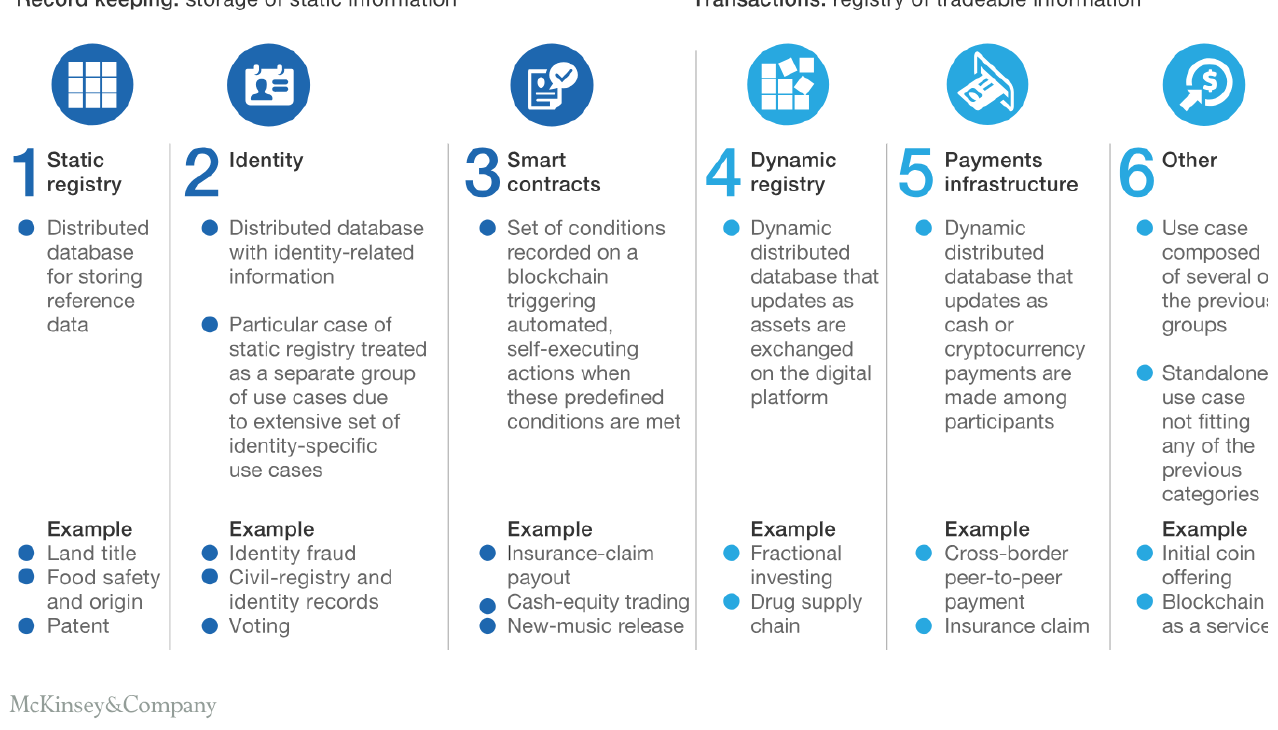
Figure 1. There are six distinct categories of blockchain use cases addressing two major needs: record keeping and transactions